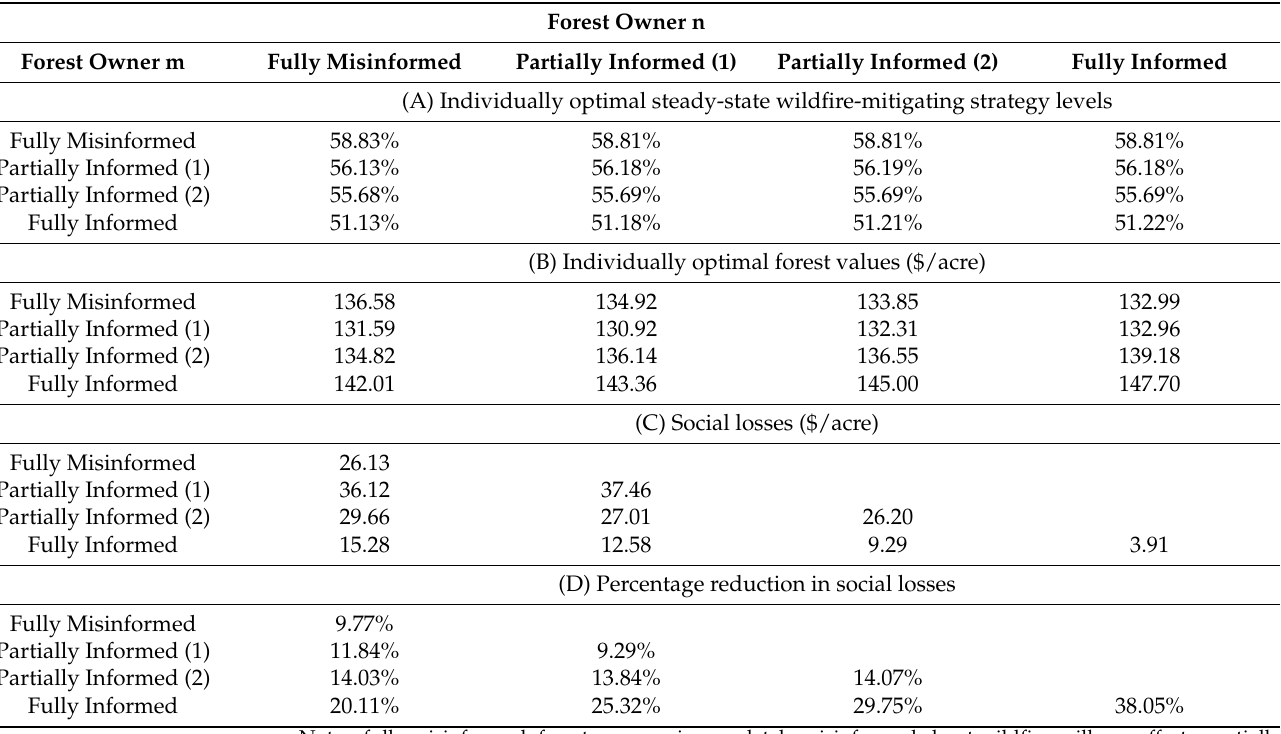
Table 3. Optimal solutions with cost-share application for forest owner m for different misinformation scenarios. Forest Owner